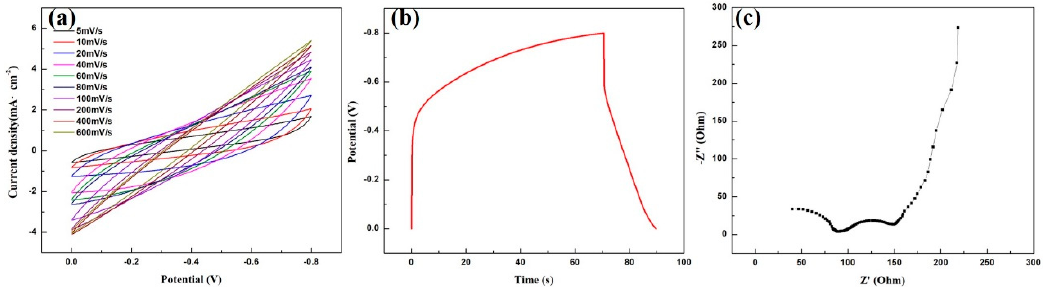
Figure 5. Electrochemical performance of the sample C-5: ( a ) cyclic voltammetry (CV) curves at a scan rate of 5-600 mV / s in potential window of − 0.8~0 V; ( b ) galvanostatic charge-discharge (GCD) curve at the current density of 0.1 mA / cm 2 ; ( c ) Nyquist impedance spectrum.